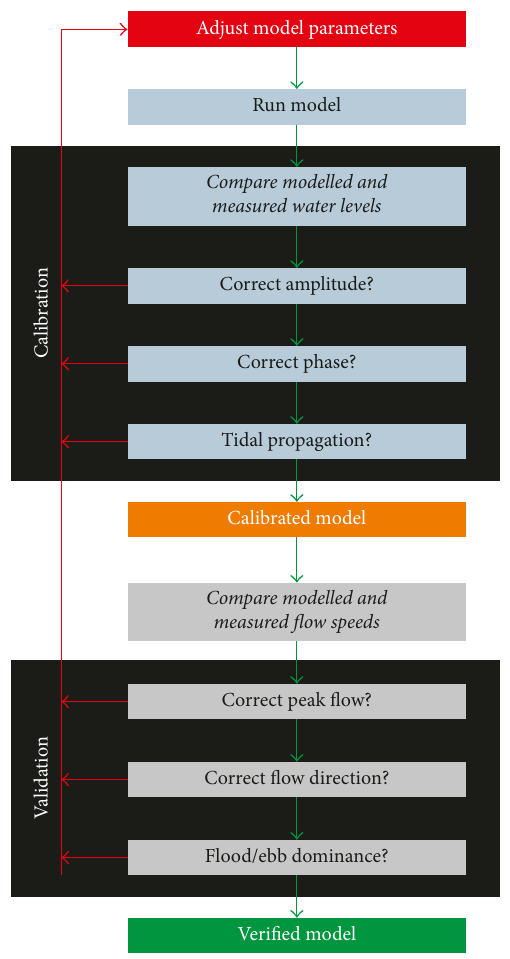
Figure 1: Schematic diagram of typical model calibration and validation steps required for a hydrodynamic